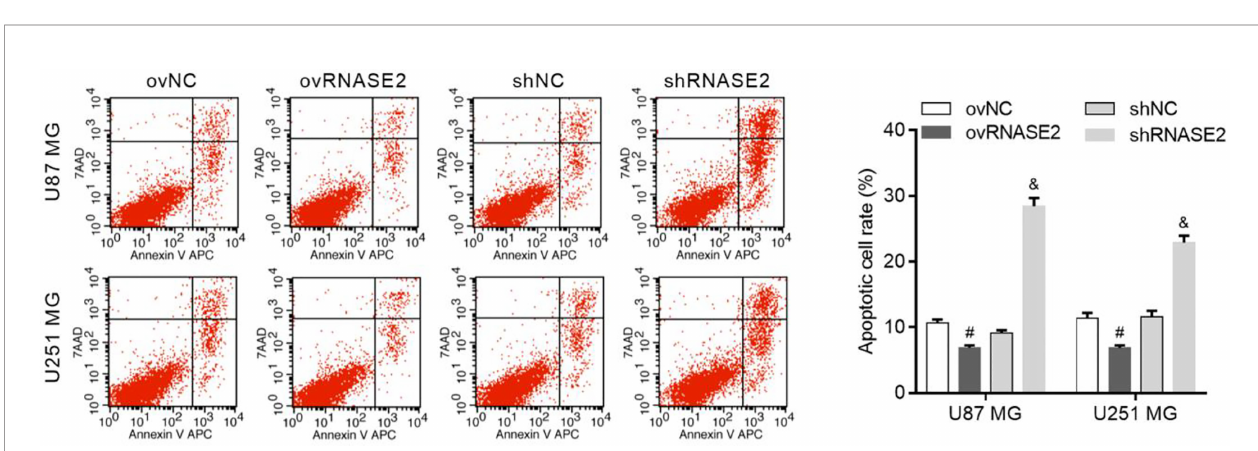
FIGURE 3 | RNASE2 overexpression suppresses the apoptosis of U87 MG and U251 MG cells, while RNASE2 knockdown promotes it. RNASE2-overexpressing (ovRNASE2) and RNASE2-silenced (shRNASE2) cells were constructed. The ovNC and shNC groups were used as control cells. # indicates p < 0.05; ovRNASE2 versus ovNC. & indicates p < 0.05; shRNASE2 versus